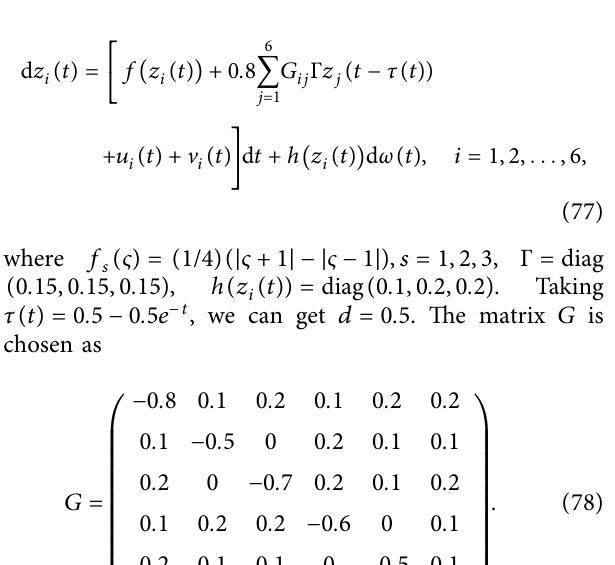
Figure 2: The error vectors e